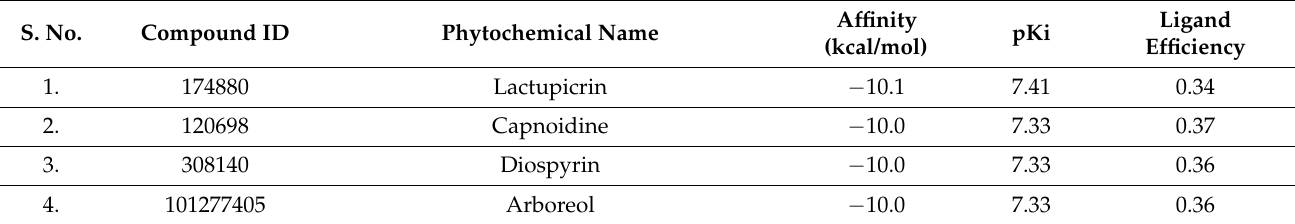
Table 1. Top 30 hits against AKT1 and their docking